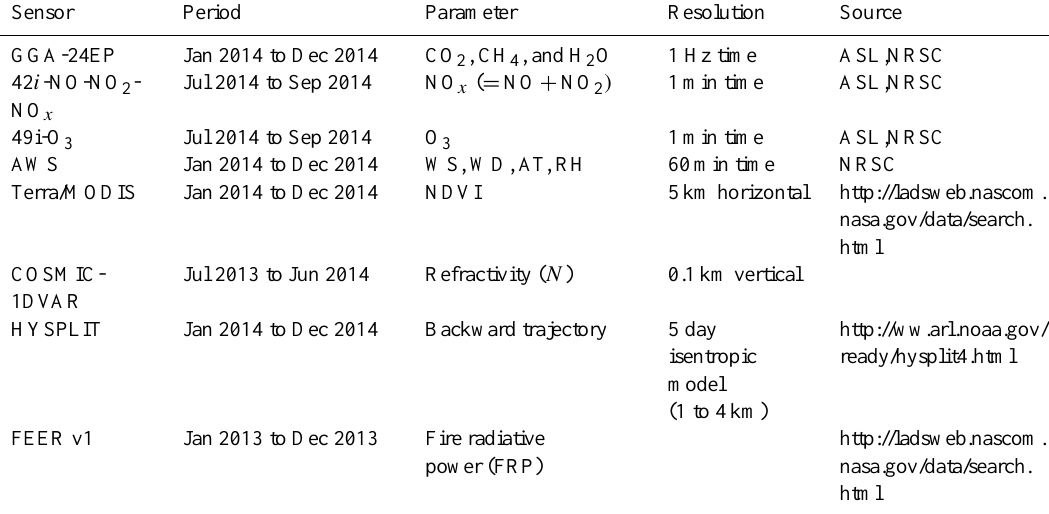
Table 1. Data used. Sensor Period Parameter